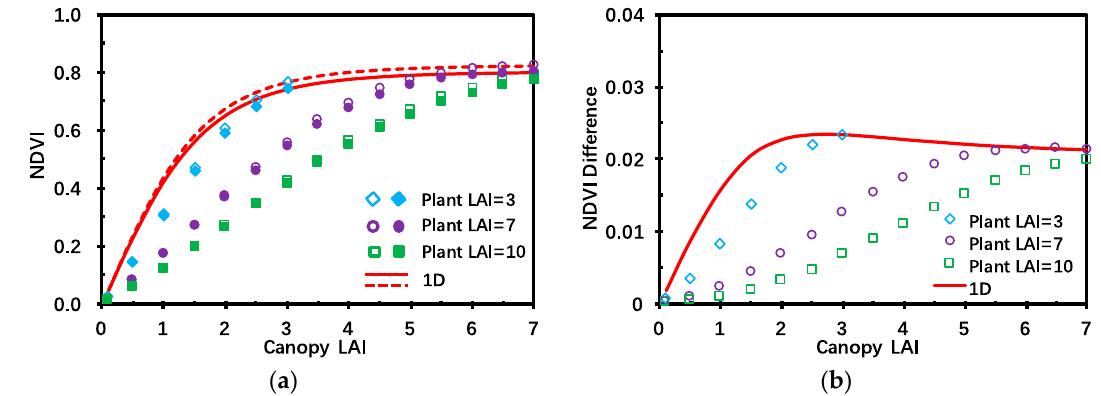
Figure 8. ( a ) Normalized difference vegetation index (NDVI) as a function of canopy LAI for four types of plant LAI. The solid symbols and line correspond to NDVI when leaf specular reflection is accounted for, whereas the hollow symbols and dashed line denote that when leaves are bi-Lambertian scatters. ( b ) Difference of NDVI when leaf specular reflection is neglected and when it is accounted for. The canopy is bounded from below by a reflective background with a surface albedo equals 0.18 at red and NIR bands. Ground cover varies with canopy LAI as LAI/7.0. Other parameters are as in Figure 6.